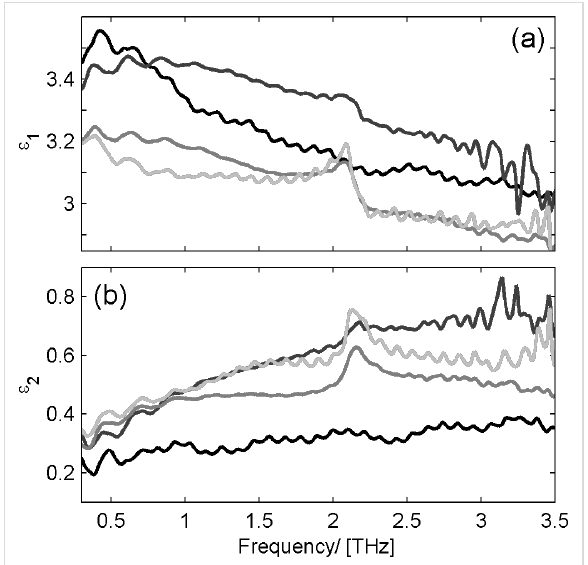
Figure 1: Figure 8 in the original article: Measured dielectric func- tion of ZnO 1 − x Cl x (a) real part; (b) imaginary part with x = 0.0% (black lines), 1.4% (dark gray lines), 1.8% (gray lines) and 2.5% (light gray lines); An infrared-active phonon at about 2 THz is scaling in intensity with increasing Cl